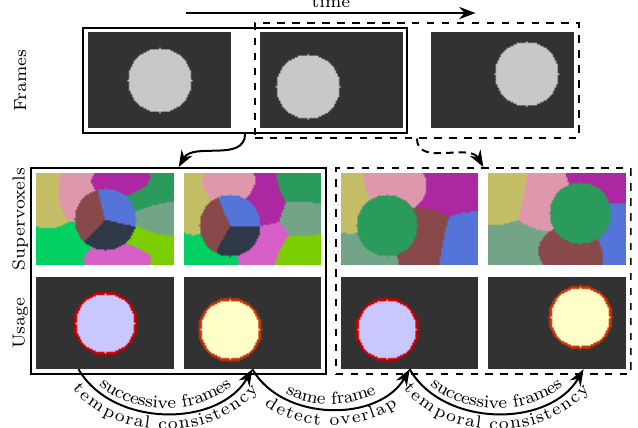
Figure 2. An illustration of a possible usage of the proposed method. The first row is three successive frames. In the second row, the first two superpixel segmentations are extracted using only the first two frames. Similarly, the last two superpixel segmentations are extracted using only the last two frames. In this example, the second frame has two superpixel segmentations. The third row explains a possible usage in foreground segmentation or object tracking, best viewed in